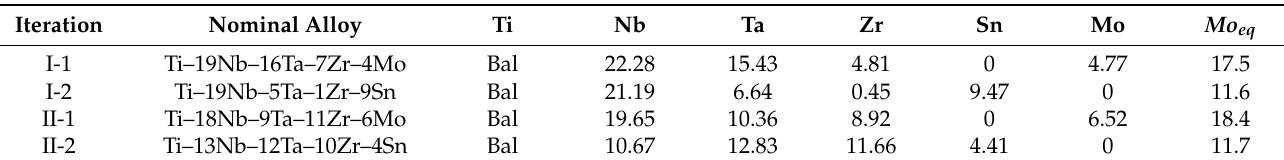
Table 3. The compositions of alloys (wt.%) were measured by EDS and all spectra were recorded at an accelerating voltage of 20 kV.